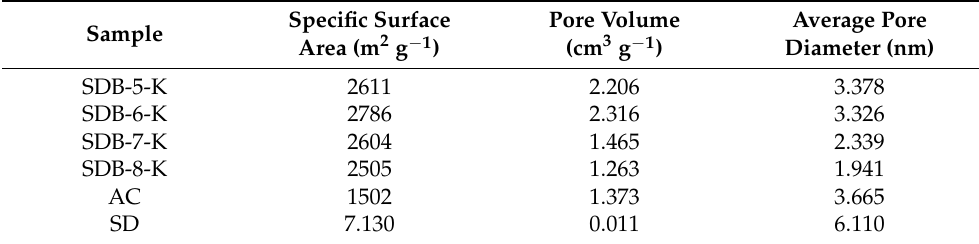
Table 1. Specific surface area, pore volume, and average pore diameter of SDBs-K, AC, and SD.